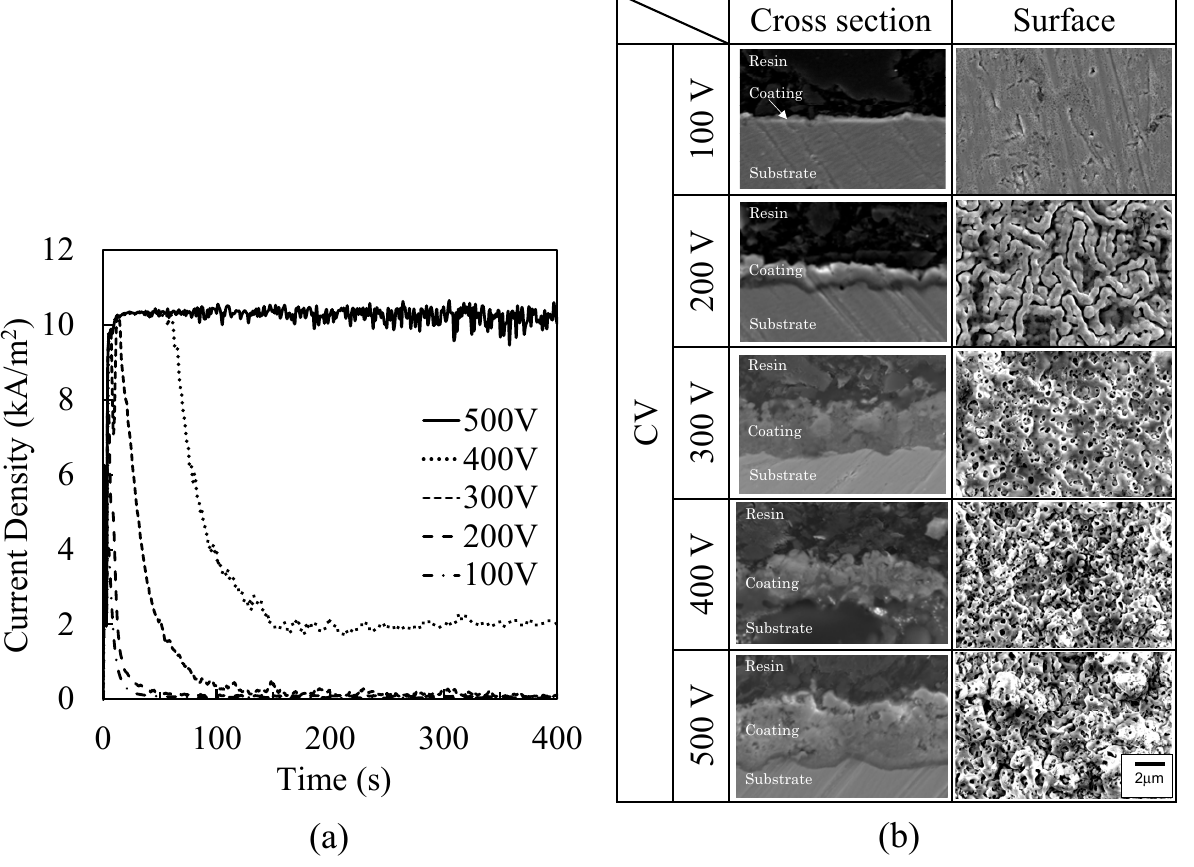
Figure 5. Current density and PEO coating by CV operation. ( a ) Time variation of current densities for a 400 s treatment time. ( b ) Cross-section and surface morphology of the PEO coating at a 60 s treatment time. Table 2. Thickness and resistivity of the PEO coating by CV operation.